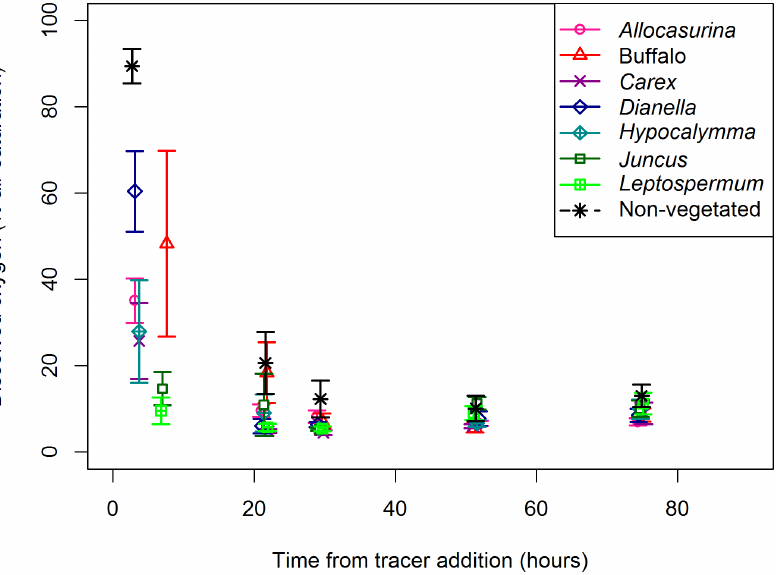
Figure 5. Change in pore water dissolved oxygen. Dissolved oxygen (% air saturated) ( 6 standard error (n=3) at base of columns across sampling period. Note the sample collection method introduced up to , 7% air saturation.